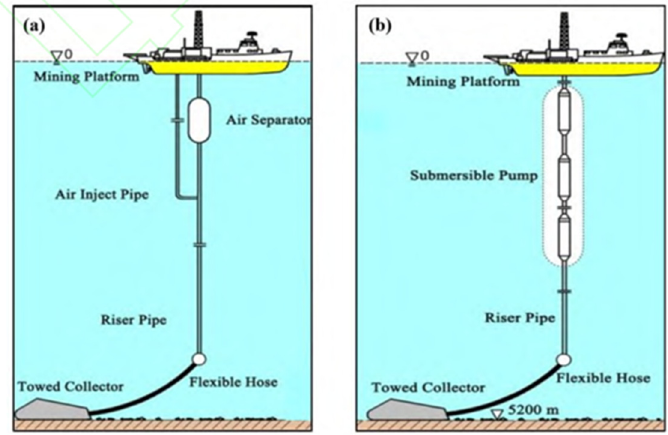
Figure 1. Schematic diagram of two deep-sea mining systems: ( a ) Pneumatic pipe lifting of deep-sea mining system; ( b ) Hydraulic pipe lifting deep-sea mining system.